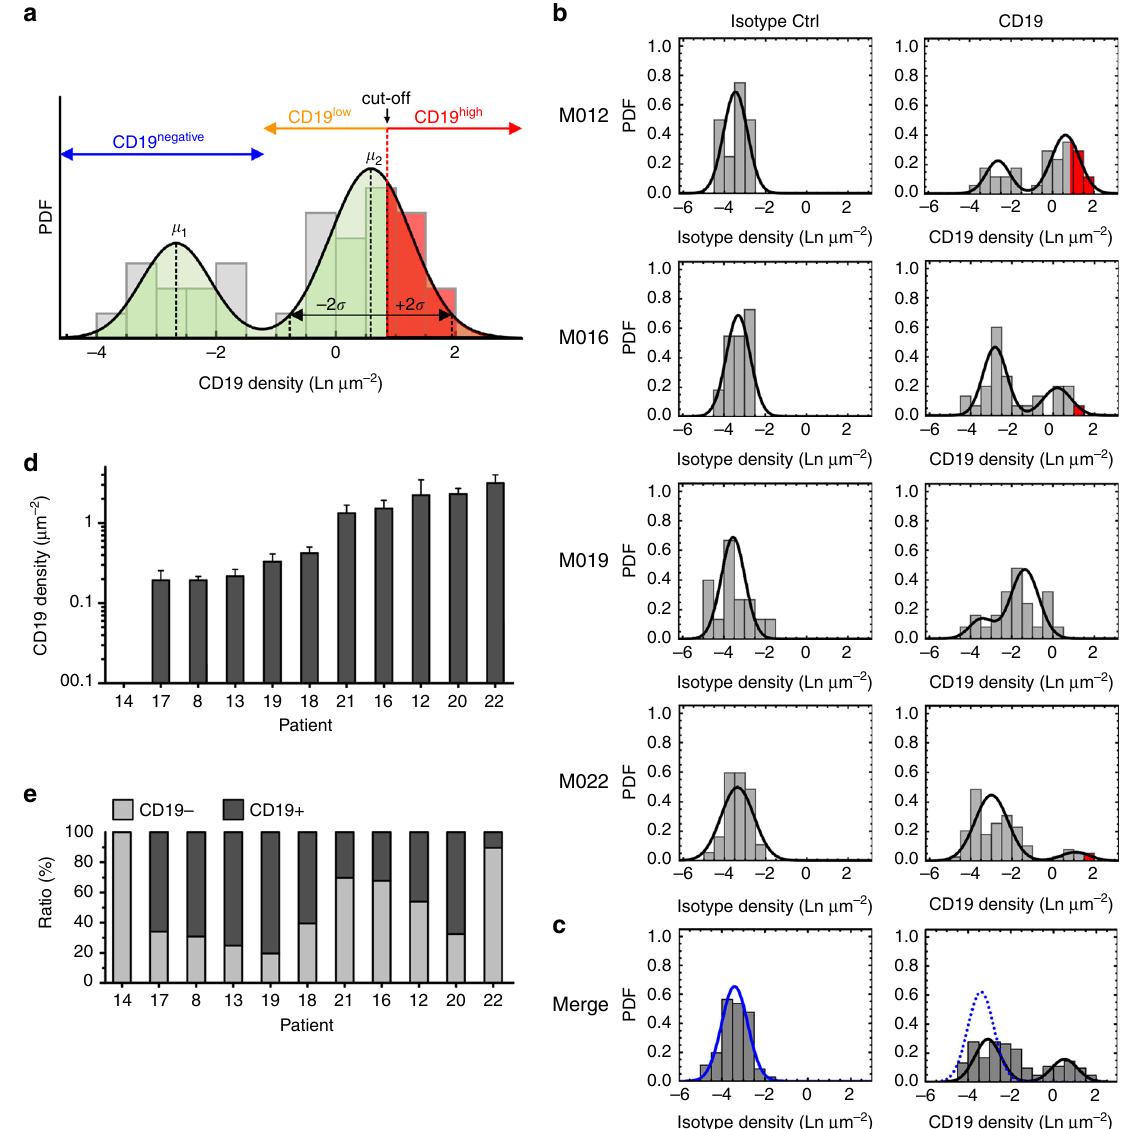
Fig. 2 CD19 expression pro fi les on myeloma cells established by d STORM. a Schematic expression pro fi le of CD19. Density distributions were divided into a CD19-positive subpopulation (CD19-positive cells) and a CD19-negative subpopulation (CD19-negative cells; blue range). The latter group was de fi ned by the density distribution pattern of the isotype control antibody (non-speci fi c binding of the control antibody to the plasma membrane and glass surface). Distributions were fi tted to a two-component log-normal function with mean ( µ ) and standard deviation ( σ ), to calculate density ranges from small ( µ − 2 σ ) to large ( µ + 2 σ ) values. The CD19-positive population was further divided into a CD19 low (orange range) and a CD19 high subpopulation (red range), based on the cutoff value of 1350 molecules per cell (see text for further details). b , c Expression pro fi les for CD19 on myeloma cells from patient M012, M016, M019, M022 and a merge c of these four patients generated by d STORM. Distribution plots show the relative CD19 density obtained after staining with isotype control (left column) and anti-CD19 antibody (right column) on myeloma cells. Densities are provided as logarithmic numbers (natural logarithm, Ln) of molecules per µ m 2 . Probability density functions (PDFs) were fi tted with a one or two-component log-normal function that was dependent on the fi t-accuracy calculated with an Anderson-Darling test (rejected at a p -value < 0.05). For each patient, the percentage of myeloma cells that had been determined to be CD19-positive by fl ow cytometry is provided for comparison (red segments). Dotted blue line in merge panel: function of the isotype control. Data for all patients are shown in Table 1 and Supplementary Fig. 4. d Mean CD19 molecule density on CD19-positive myeloma cells in molecules per µ m 2 as assessed by d STORM imaging in n = 10 CD19-positive myeloma patients, and one CD19-negative patient (M014) for comparison. Error bars represent standard deviations of the means from repeated random sampling of the estimated log-normal distribution. e Percentages of CD19- positive and CD19-negative cells, ranging from 10% (M022) to 80% (M019) of CD19-positive cells among